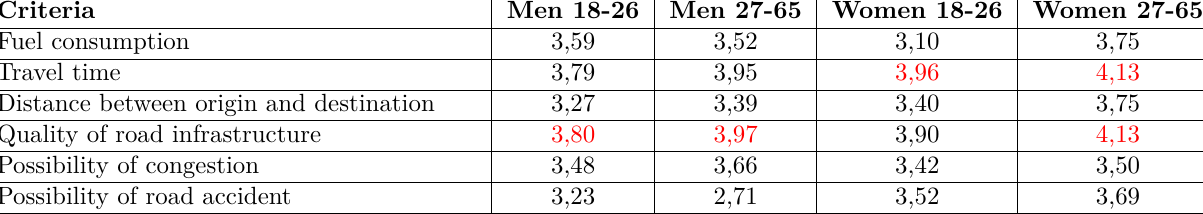
Table 3. Criteria for route selection – weighted arithmetic mean.